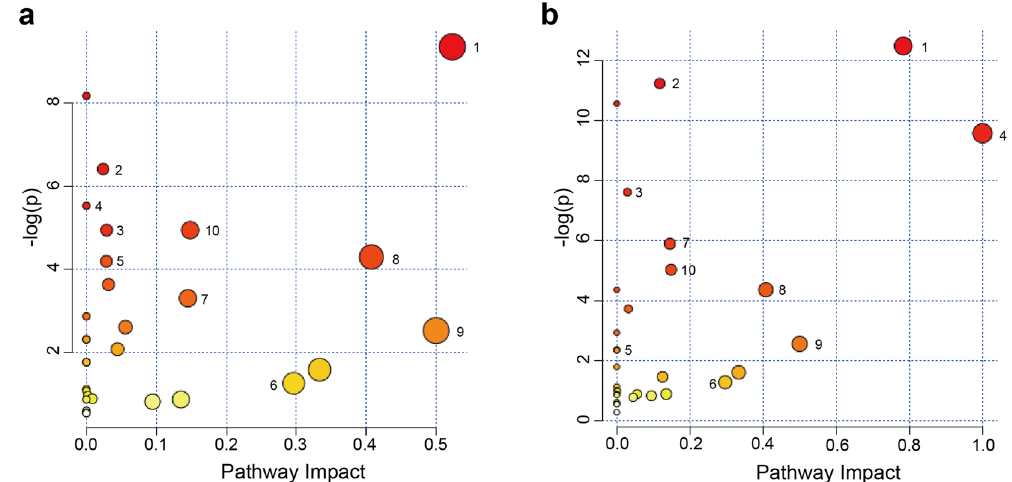
Figure 6. Bubble plots of altered metabolic pathways in multiple bio-samples (serum, urine, and cortex extract). ( a ) shows comparison between SMFY and control, and ( b ) between GMFS and control. Bubble area is proportional to the impact of each pathway with colour denoting the significance from highest (in red) to lowest (in white). 1, alanine, aspartate and glutamate metabolism; 2, arginine and proline metabolism; 3, butanoate metabolism; 4, D-glutamine and D-glutamate metabolism; 5, glycolysis or gluconeogenesis; 6, glyoxylate and dicarboxylate metabolism; 7, histidine metabolism; 8, phenylalanine metabolism; 9, phenylalanine, tyrosine and tryptophan biosynthesis; 10, TCA